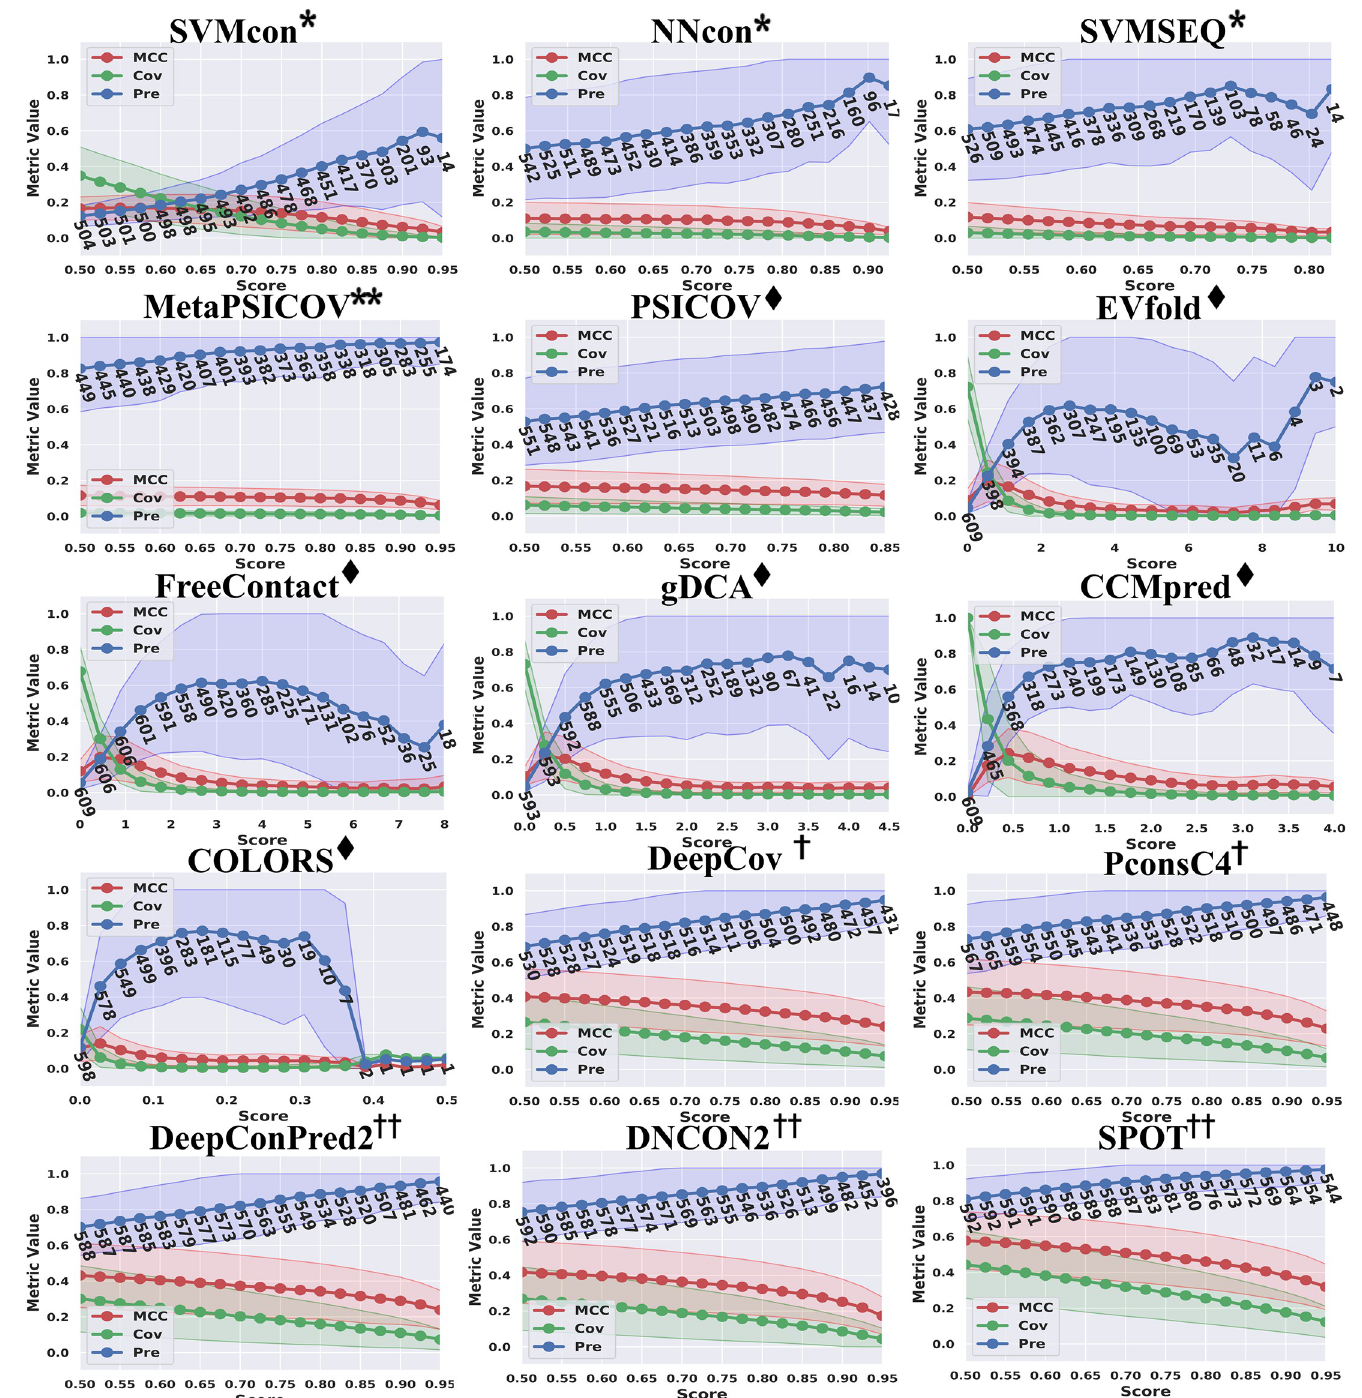
Fig 3. Prediction performance in terms of precision, coverage, MCC and the corresponding standard deviation (the shaded area around the curves) with the increasing probability (score) threshold given by the predictors. For the methods with probability (score) distribution between [0,1], the x-axis uses 0.5 as the starting threshold, and for some ECA methods with wider probability (score) distribution ranges, the x-axis starts at 0. The numbers under the precision curve (blue) are the numbers of proteins with predictions returned using the corresponding probability (score) threshold on the x-axis. DL methods show much higher reliability in model probability (score) compared with ML and ECA